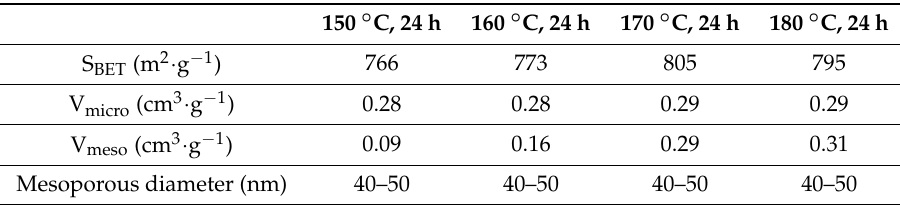
Table 2. Specific surface area, microporous and mesoporous volumes of the four synthesized zeolite ZK-4